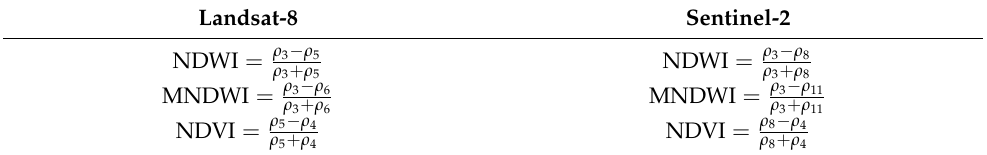
Table 2. Specification of bands used in the multispectral indices’ calculation for both data sources.